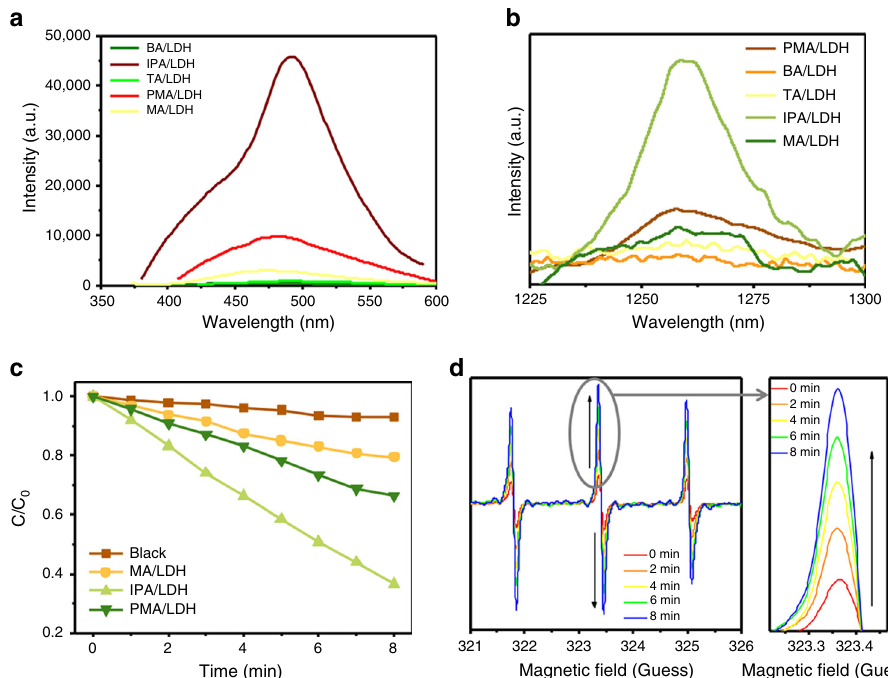
Fig. 2 Optical characterization and identi fi cation of 1 O 2 generation. a Photoemission spectra of BA/LDH, IPA/LDH, TA/LDH, PMA/LDH, and MA/LDH nanohybrids TPA excitation by an 808 nm laser at the same power. b 1 O 2 emission at around 1270 nm induced by BA/LDH, IPA/LDH, TA/LDH, PMA/ LDH, and MA/LDH nanohybrids in water. c Normalized absorbance of DPBF in the presence of IPA/LDH, PMA/LDH, and MA/LDH nanohybrids in air. d Time-dependent ESR spectra of IPA/LDH nanohybrids in the presence of